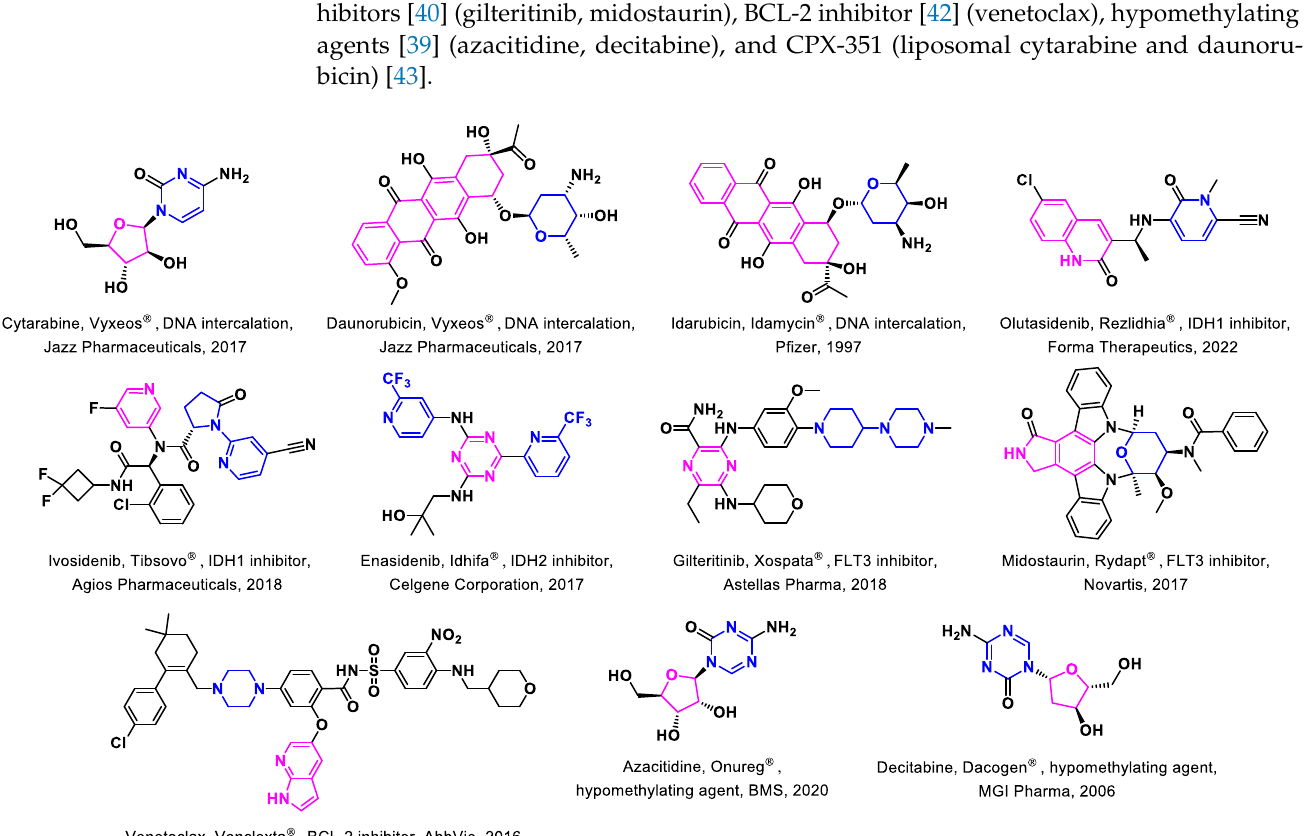
Figure 1. FDA-approved drugs for the treatment of acute myeloid leukemia (AML). The structure of standard chemotherapies—cytarabine, anthracyclines such as daunorubicin or idarubicin, and the small molecule FDA-approved drugs—included IDH inhibitors, FLT3 inhibitors, BCL-2 inhibitors, hypomethylating agents, and CPX-351. Abbreviations: DNA: deoxyribonucleic acid; IDH1/2: isocitrate dehydrogenase ½; FLT3: FMS like tyrosine kinase 3; BCL-2: B-cell lymphoma 2; BMS: Bristol Myers Squibb.